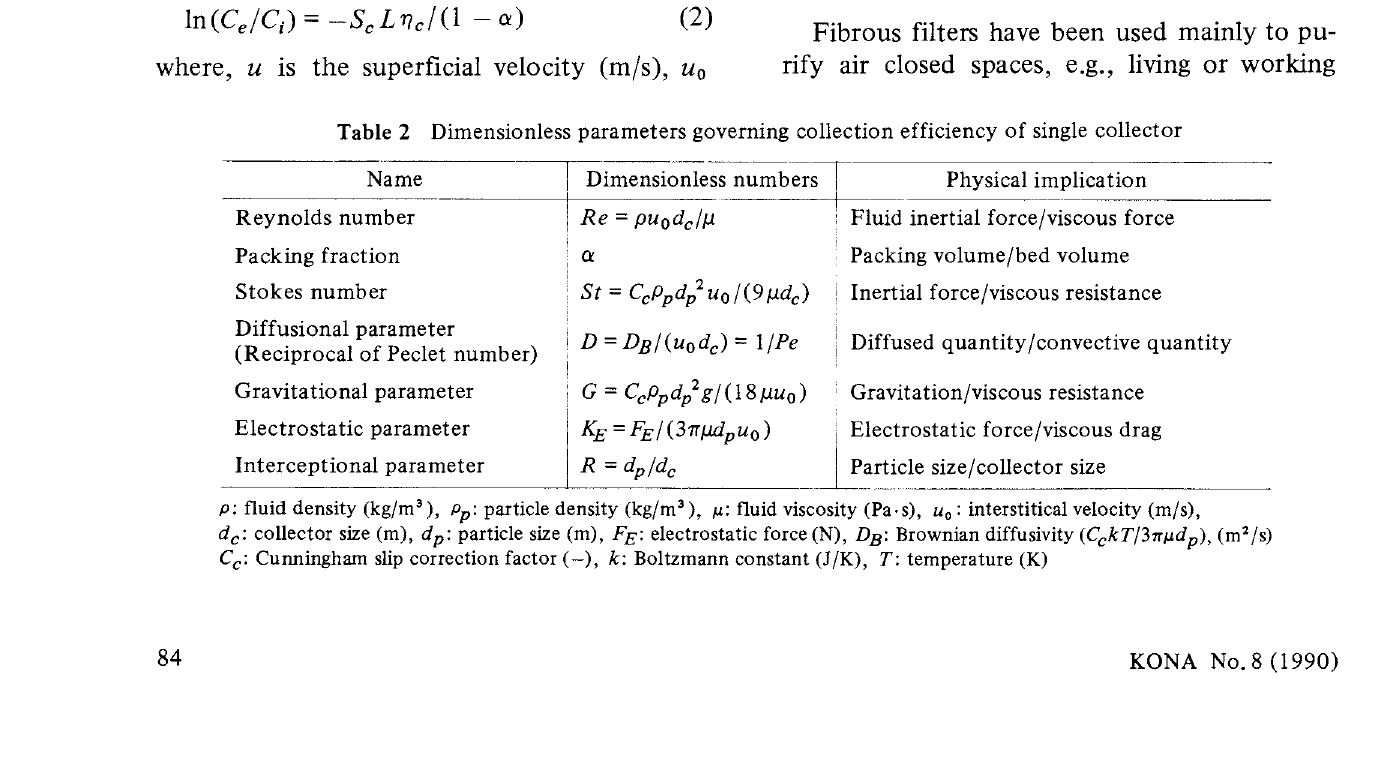
Fig. 2 Change of aerosol concentration in a packed bed and collection efficiency of single collector